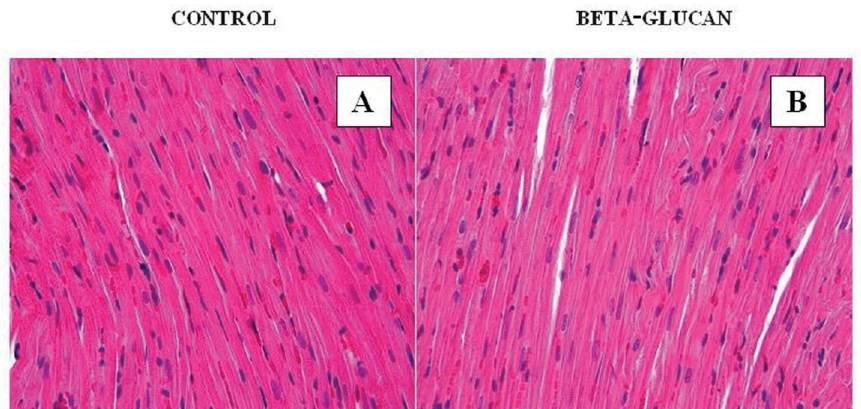
FIGURE 1 - Control and Beta glucan group . In control and beta-glucan groups heart tissue showing the normal appearance of cardiac myofibres. (A): H-E; X40, (B): H-E;